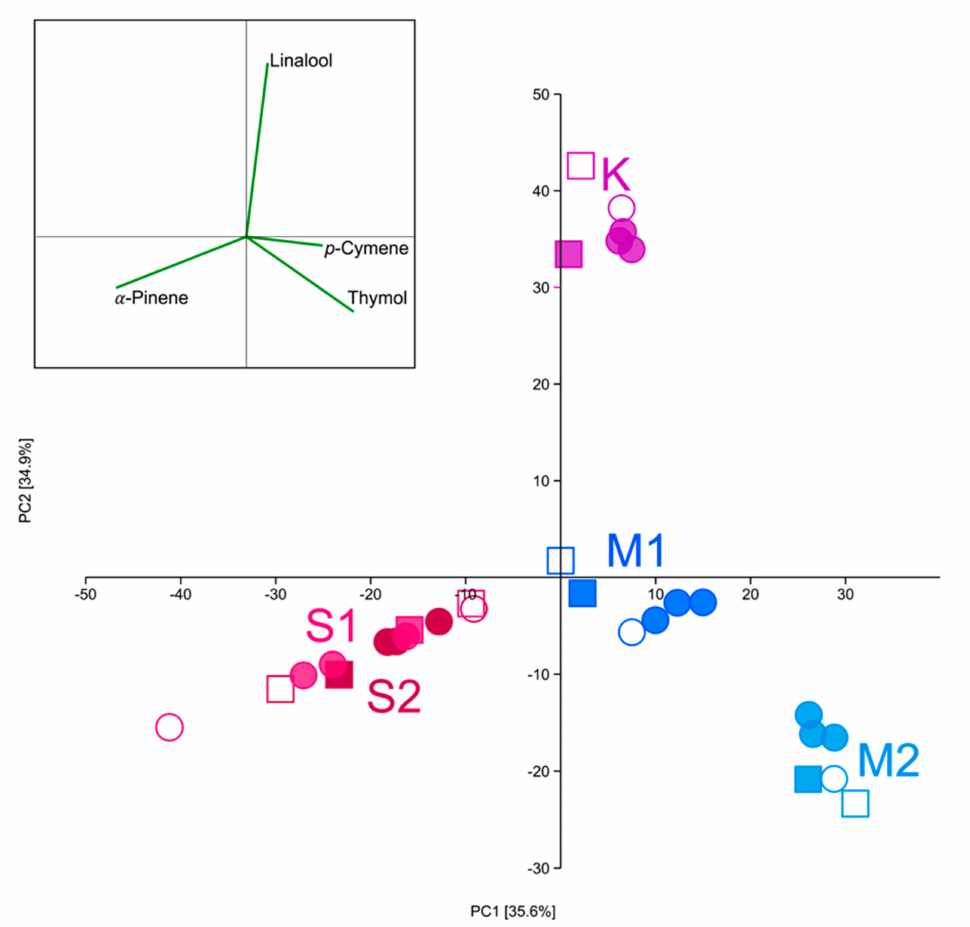
Figure 6. The principle component analysis (PCA) scatter plot with all samples based on 16 components from the EO with principle vectors; M1: Satureja montana from the mountain region; M2: Satureja montana from the coastal region; K: S. kitaibelii ; S1: S. subspicata subsp. liburnica; S2: S. subspicata subsp. subspicata ; (cid:4) : Calyx; (cid:3) : Corolla; • : Leaf;